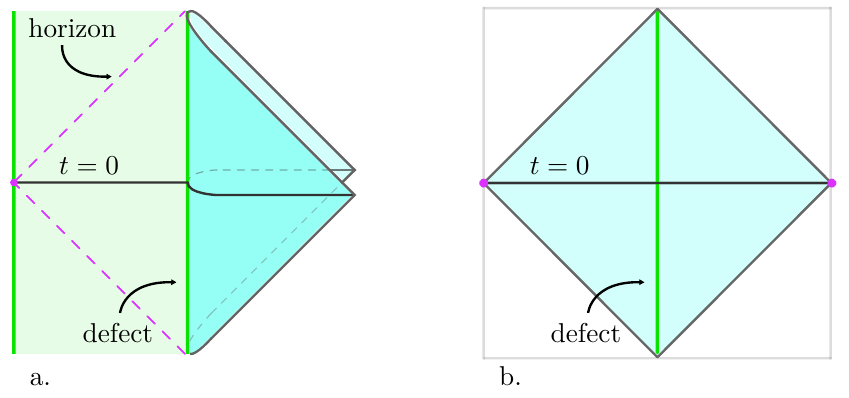
Figure 19. The brane and boundary perspectives of the extremal black hole